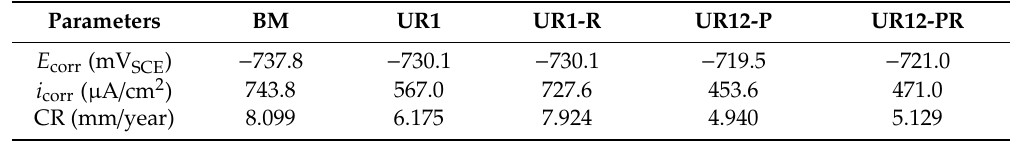
Table 4. Electrochemical corrosion parameters of di ff erent